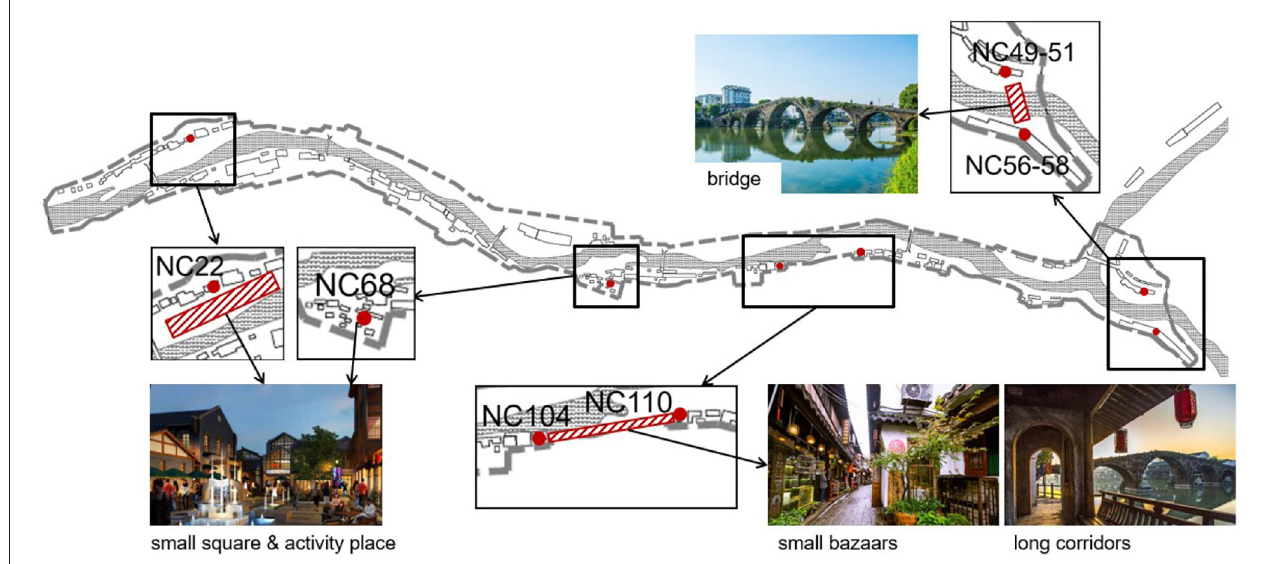
FIGURE 6 | Strategies of the added public infrastructures and activity places in Ningchang